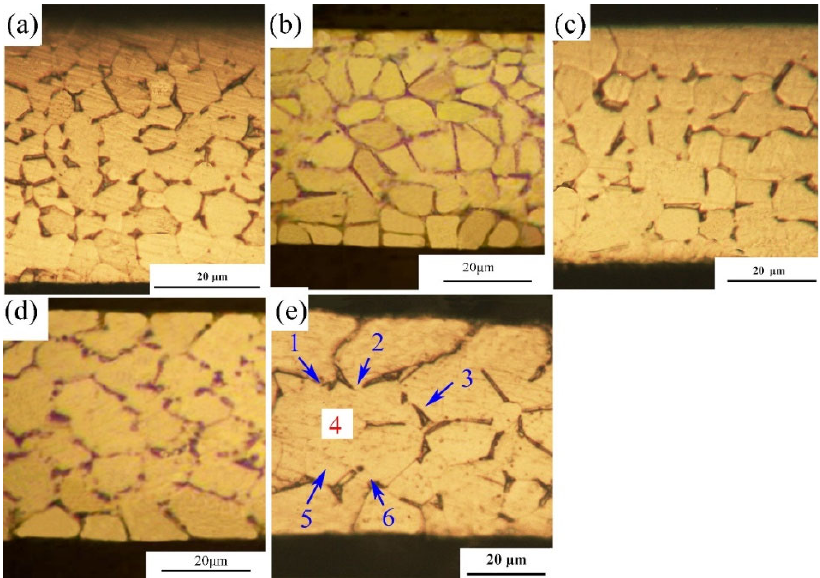
Figure 1. Microstructures of Ti ‐ 2.5Al ‐ 1.5Mn foils: ( a ) t/d = 13.43, ( b ) t/d = 9.37, ( c ) t/d = 7.68, ( d ) t/d = 5.14, ( e ) t/d = 3.32.